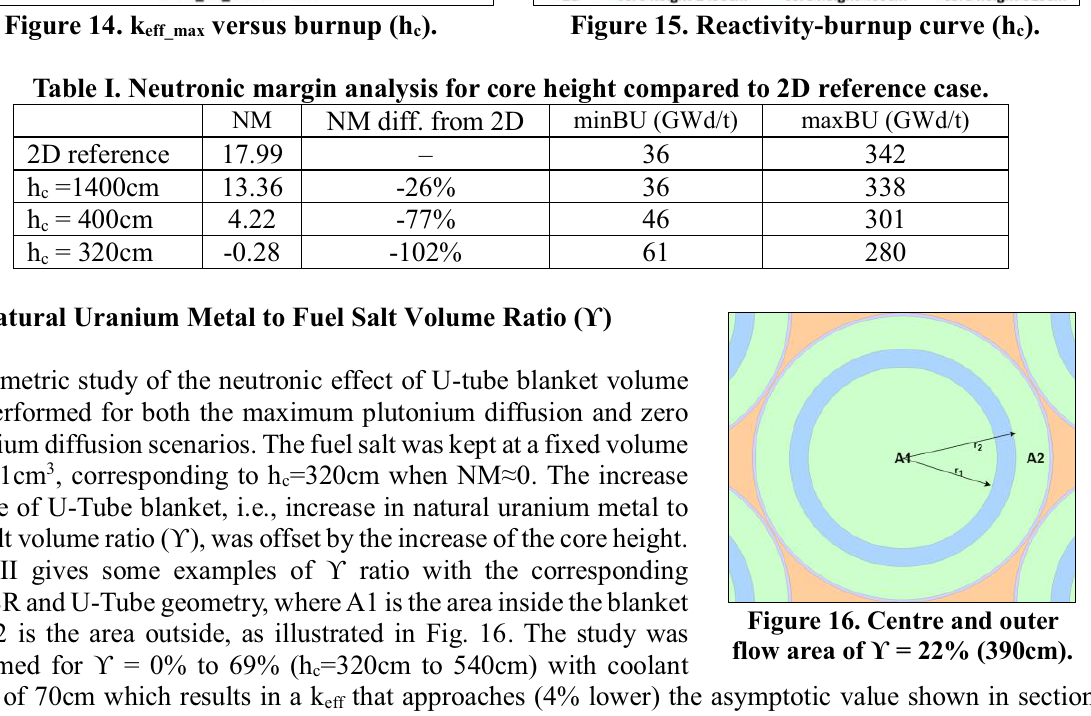
). Figure 15. Reactivity-burnup curve (h c